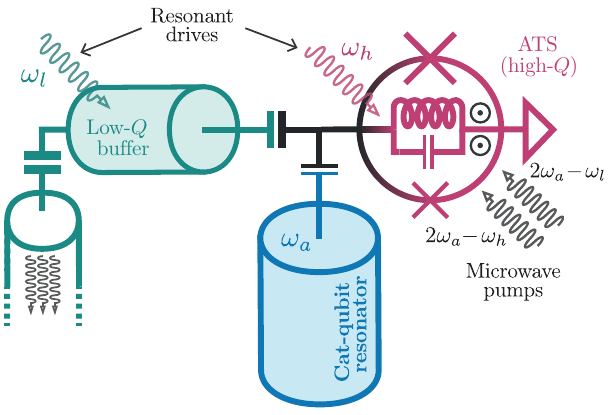
FIG. 12. Superconducting circuit schematic of a combined TPE and two-photon dissipation confinement. The cat-qubit res- onator (blue) is capacitively coupled to an ATS (black) that mediates two-photon exchanges both with its self high- Q mode (magenta) and with a low- Q buffer mode (green). The ATS is dc biased at the normalized flux (0, π ) working point and pumped at frequencies 2 ω a − ω h and 2 ω a − ω l , where ω a , ω h , and ω l are the resonant frequencies of the cat-qubit resonator, high- Q buffer and low- Q buffer, respectively. To ensure the anharmonicity of the ATS mode (magenta), the ATS junctions are designed to admit slightly different Josephson energies. In addition, both buffers are resonantly driven to control the cat-qubit mean number of